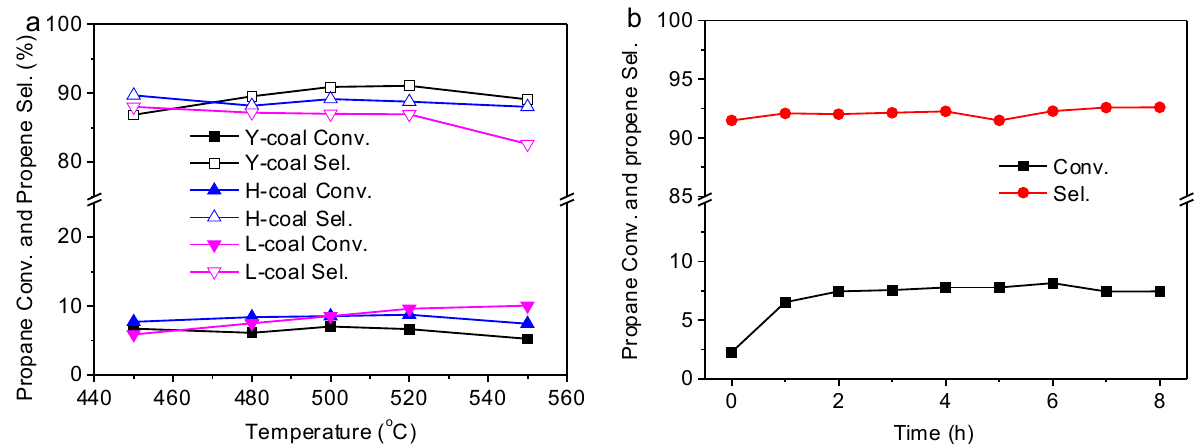
Figure 1. ( a ) Catalytic performances of three coal samples. ( b ) The long-time performance of L-coal at 480 ◦ C. Reaction conditions: 15 kPa O 2 , 30 kPa C 3 H 8 , N 2 balance, mass space velocity 4000 mL · (h · g-cat) − 1 , 0.3 g catalyst.